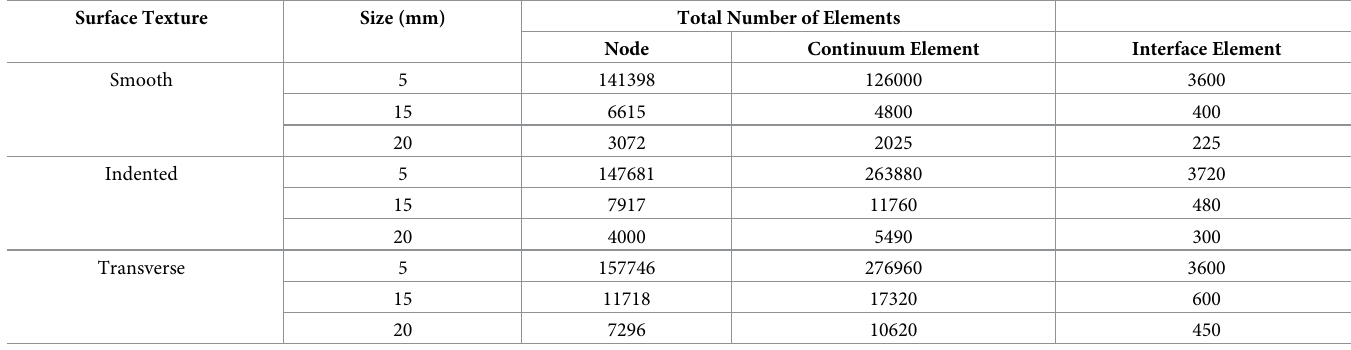
Table 2. Finite element mesh densities for all